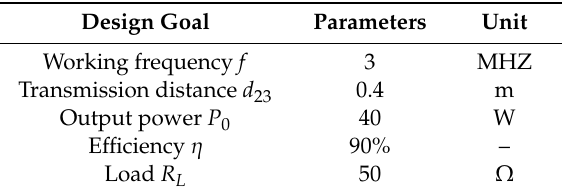
Table 1. System design goals of WPT system.